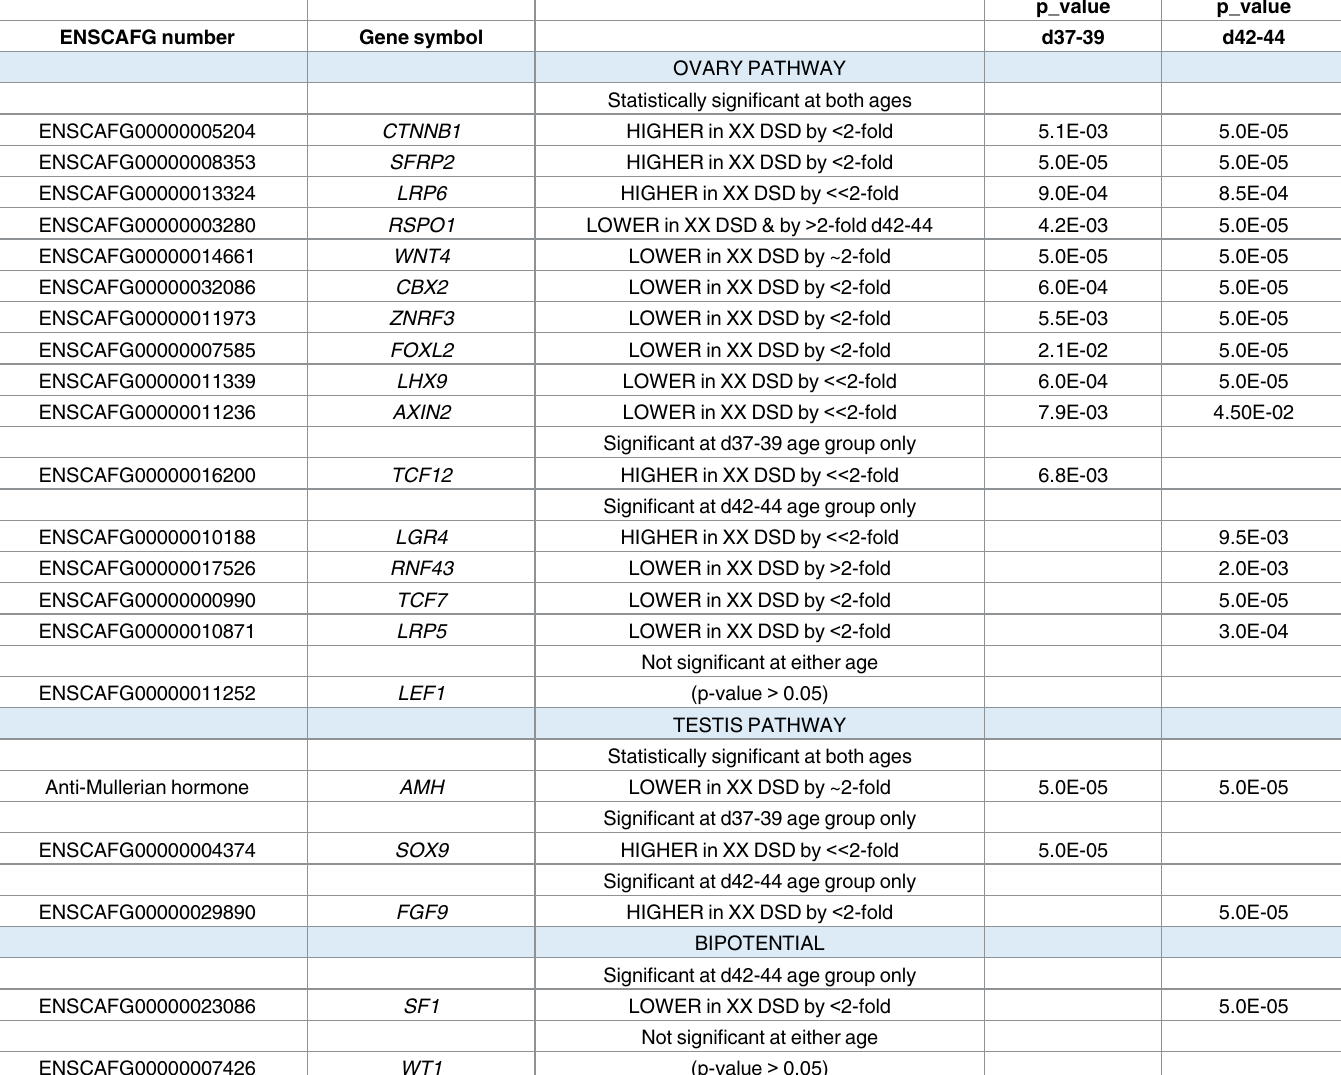
Table 5. Ovary and testis pathway gene expression was measuredby